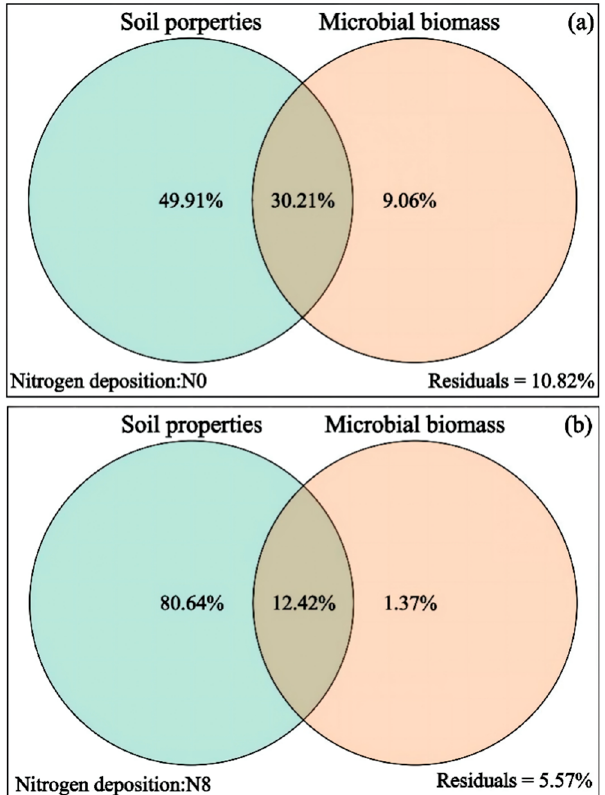
Figure 7. Variation partitioning analysis of the relative contributions of soil properties and microbial biomass to variation in plant diversity; ( a ) Nitrogen deposition level is N0; ( b ) Nitrogen deposition level is N8.